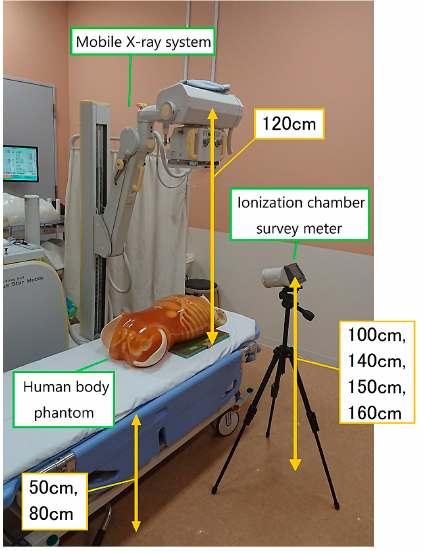
Figure 1. Experimental setup. The measurement points of 140 and 160 cm roughly correspond to the position of the eye lens of the radiological technologist.